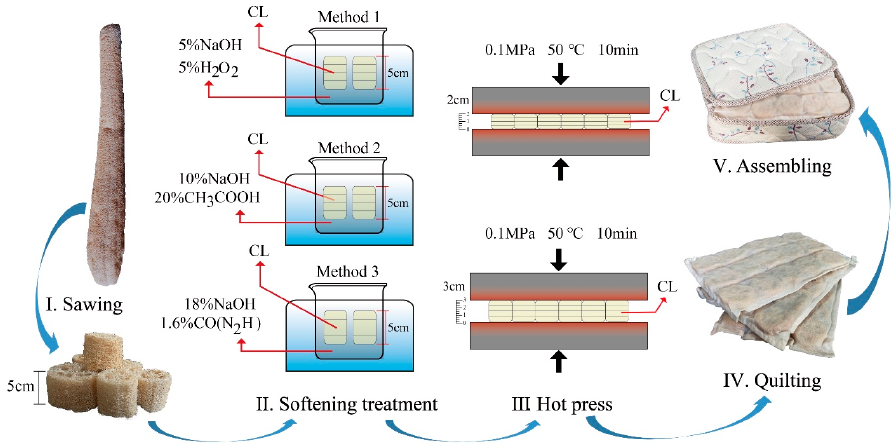
Figure 2. Preparation process of luffa filling material of mattress